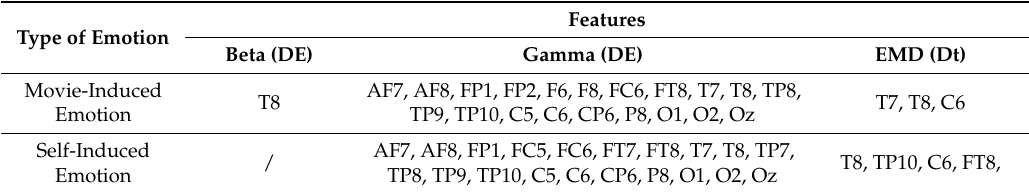
Table 7. Top 20 electrodes for the classification of emotions into six discrete categories (Electrodes are selected in accordance with MRMR ranking).